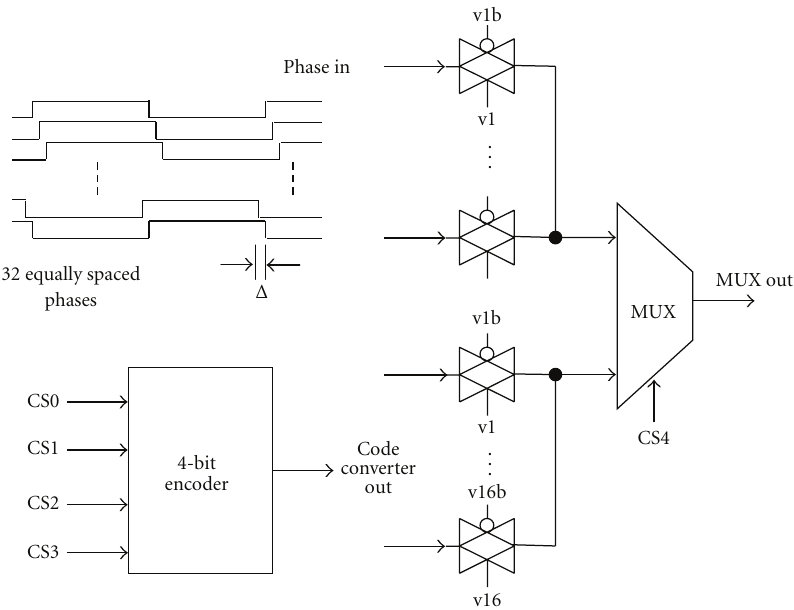
Figure 12: Transmission gate-based 32-to-1 MUX.